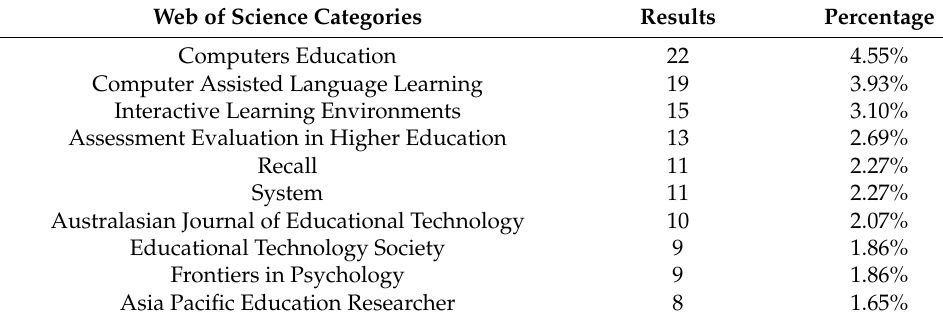
Table 2. The top 10 journals in the search results.